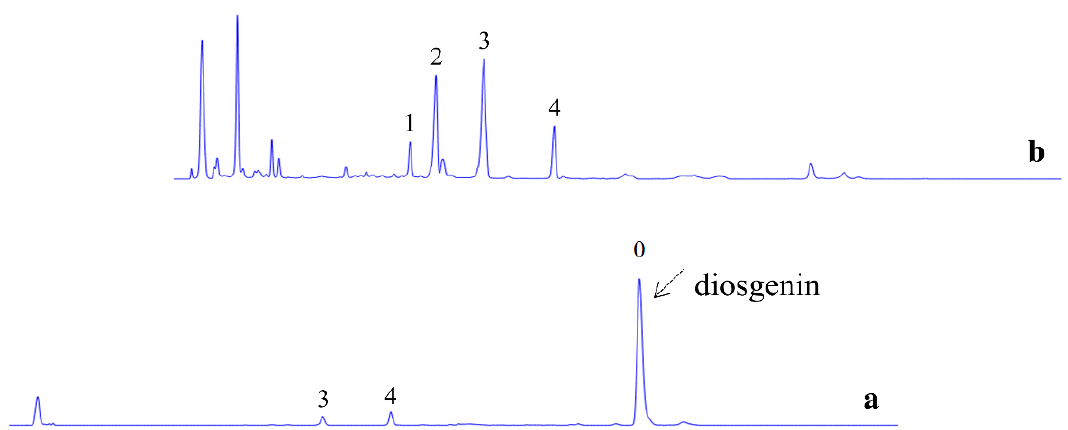
Figure 4. HPLC-ELSD analysis of products and substrates. ( a ) Profile of diosgenin from DZW. The arrow indicates the product of diosgenin (0). The main residuals were prosapogenin A (3) and trillin (4). ( b ) Profile of DZW before microbial biocatalysis. DZW was mainly composed of zingiberensis newsaponin (1), deltonin (2), prosapogenin A (3), and trillin (4).